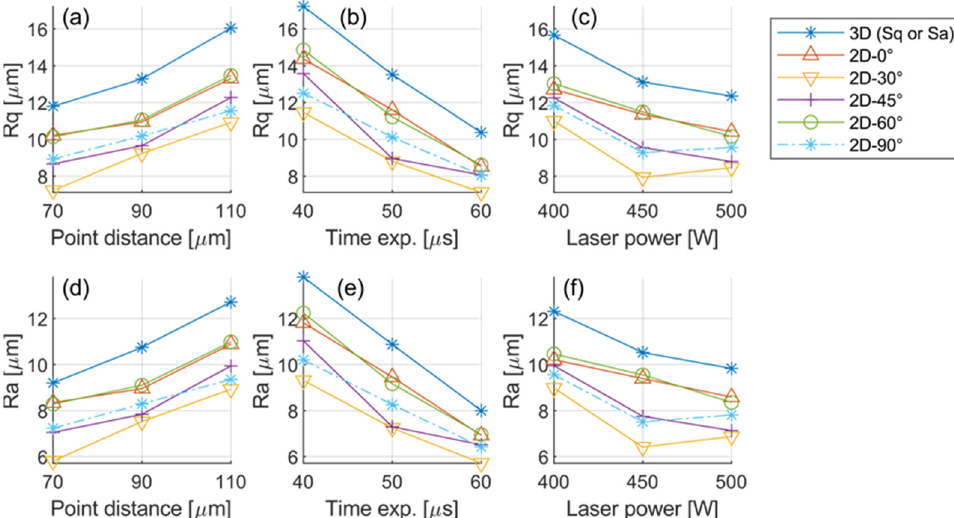
Figure 9. Influence of process parameters on ( a – c ) Rq and ( d – f ) Ra (Sq and Sa for 3D data) evaluated along x and y axis. Effect of ( a , d ) point distance, ( b , e ) time exposure (exp.) and ( c , f ) laser power.